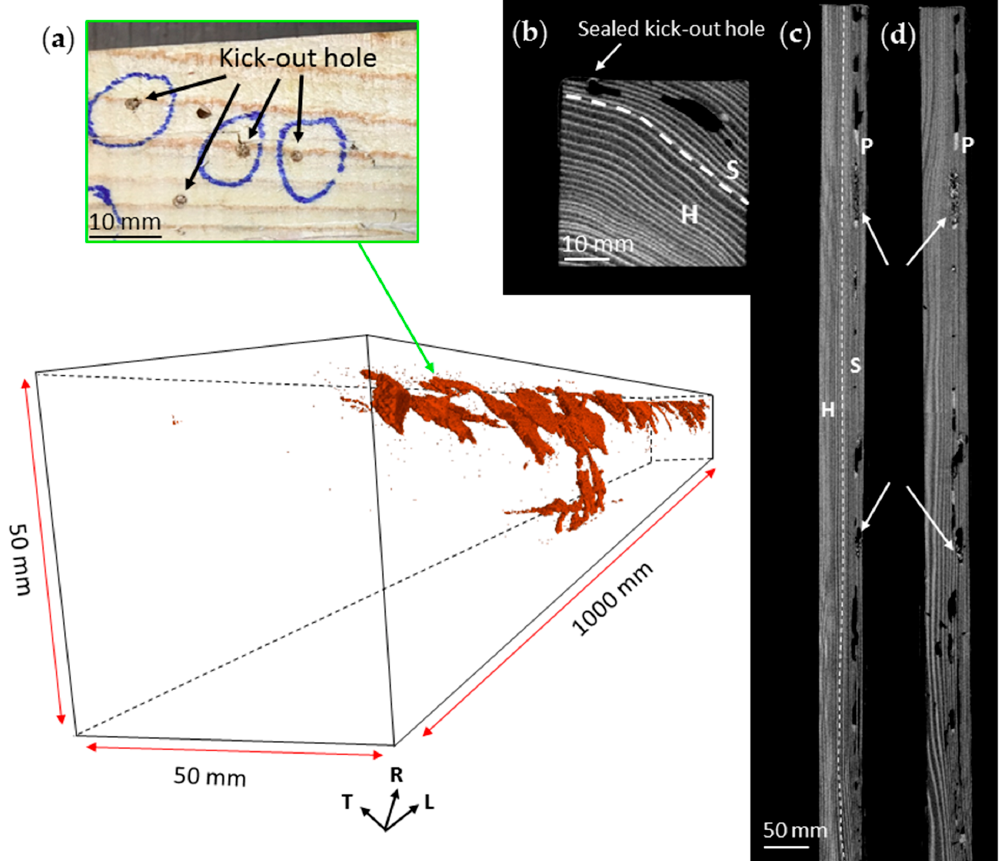
Figure 5. CT images of a nest-gallery system in Sugi timber. ( a ) A close up view of “kick-out holes”, i.e., holes to dispose pellets from the nest-gallery; ( b ) a 2D cross-sectional image; ( c ) a 2D radial image, indicating that the nest-gallery was extensively excavated all over the timber along the sapwood part, parallel to the longitudinal axis of the timber; and ( d ) a 2D tangential image of the sapwood. In 2D CT images, the gray value of a pixel corresponds to an index of density: the lighter the color, the denser the area. Springwood and summerwood are indicated by darker and lighter colors in the images, respectively. The arrow axis represents the longitudinal (L), radial (R), and tangential (T) directions of the timber. S, sapwood; H, heartwood; P, fecal pellets.